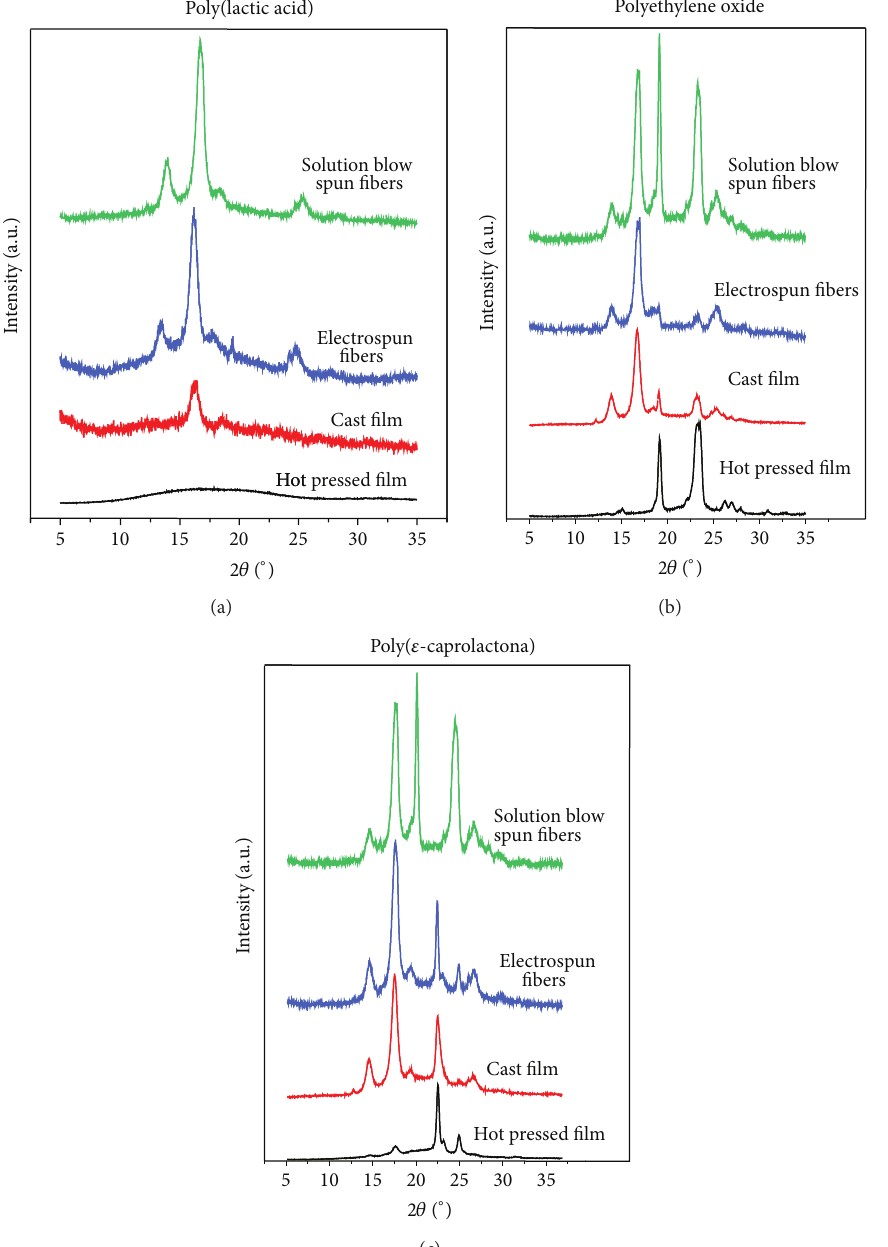
Figure 6: XRD patterns for (a) PLA, (b) PEO, and (c)